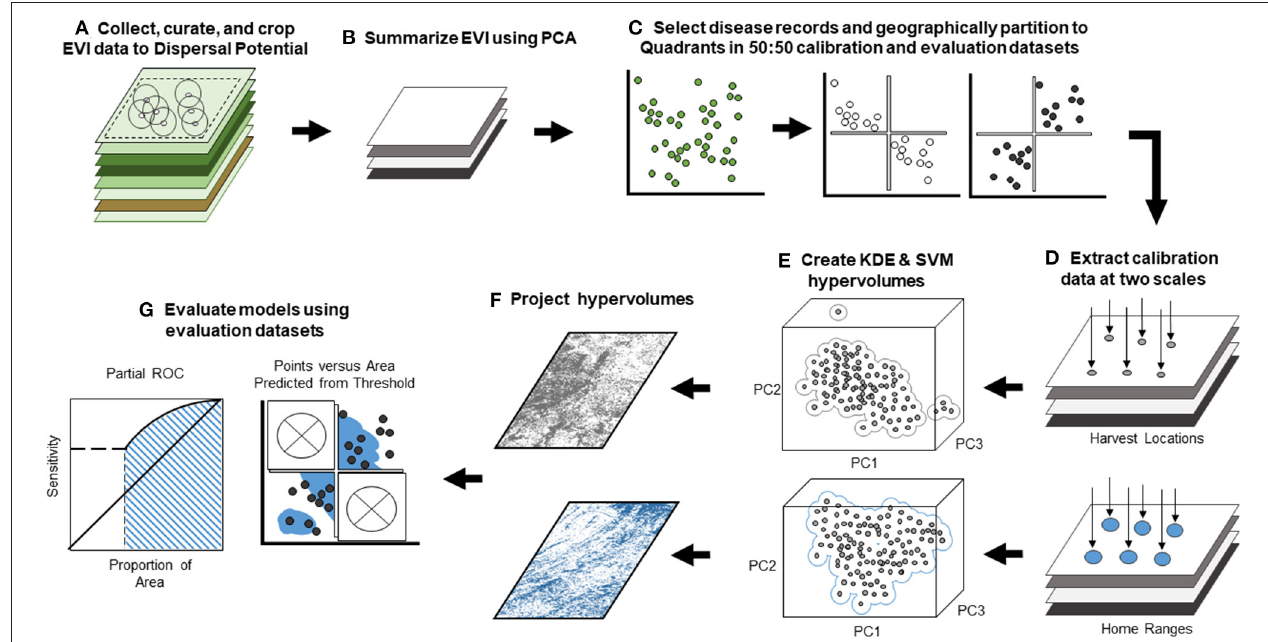
FIGURE 3 | Workflow of black-box landscape epidemiology analysis. Workflow displays our black-box framework and evaluation procedure. (A) We collected remotely sensed enhanced vegetation index (EVI) and cropped rasters to the extent of the maximum dispersal potential for our focal species as radii about disease records (for details, see Figure 2 ). (B) We performed a principal component analysis on the EVI data to reduce multicolinearity and generate dimensions in analysis. (C) Next, we selected only disease occurrence locations and partitioned data into geographic quadrants for calibration and evaluation datasets. (D) We extracted principal component data from the PCA-generated raster stack at both Harvest Location (the single 250m × 250m raster pixel value corresponding to the precise sampling coordinate) and Home Range scales (a summary of values from multiple 250m × 250m pixels surrounding precise sampling coordinate) inferred from the home range size of focal species. (E) We developed 24 hypervolumes using Gaussian kernel density estimation and a one-class support vector machine for all six quadrant combinations and both scales. (F) Each hypervolume was projected onto geography in the form of binary risk maps, but KDE hypervolumes were additionally projected into continuous risk maps. (G) We used models to generate risk maps and evaluated models using methods appropriate for the projection: cumulative binomial probability testing (for binary maps) (69) and partial ROC (for continuous maps) (68). To more rigorously test models, we penalized suitability inherent to calibration data and restricted each map to evaluation dataset quadrants (represented by “ ×